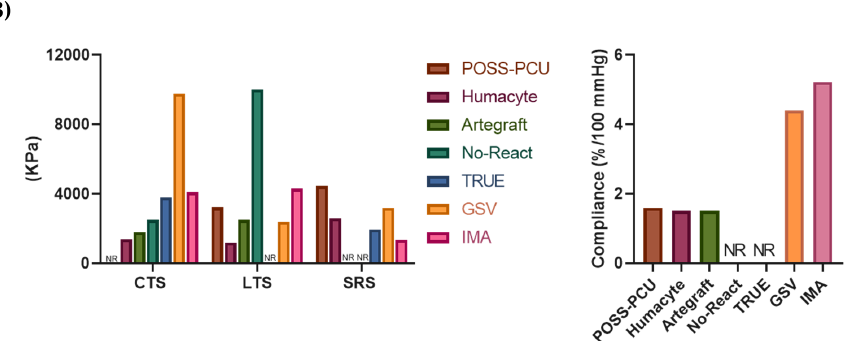
Figure 6. ( A ) Mechanical properties comparison of great saphenous vein, as a gold standard, and grafts in clinical trials. Mechanical properties identified include internal diameter (ID), wall thickness (WT), longitudinal tensile strength (LTS), circumferential tensile strength (CTS), suture retention strength (SRS), burst pressure (BP), and dynamic compliance (DC). Chart generated from the Python library developed by StatsBomb/Anmol Durgapal (accessed on 29 May 2022) [29]. ( B ) Mechanical properties comparison of great saphenous vein, as a gold standard, internal mammary artery, and each graft made in clinical trials. Circumferential tensile strength (CTS), longitudinal tensile strength (LTS), suture retention strength (SRS), internal mammary artery (IMA), and great saphenous vein (GSV). Data are according to literature reports of a representative data set. Additional information regarding descriptive analysis can be found in Table S1. Graph generated with GraphPad Prism (accessed on 29 May 2022).